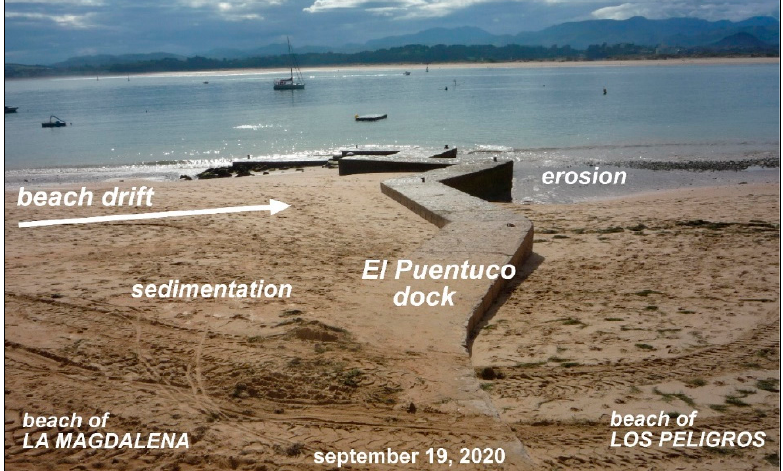
Figure 9. El Puentuco dock is situated at the dividing point between Zone 2 (La Magdalena) and 3 (Los Peligros). It has been covered by sand in the last decades and became visible in 2020 after the construction of the breakwater. Now, it retains part of the sand drift from La Magdalena.